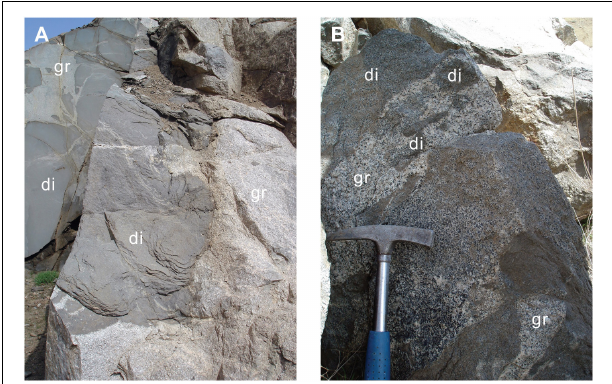
FIGURE 2 | Contact relations between dioritic (di) and granitic (gr) rocks of the Takht batholith. (A) Dioritic rock in sharp contact with and apparently cut by granitic rock; note the network of dikelets connecting to the main mass of granitic rock. (B) Centimeter-sized enclaves of diorite occur in granitic rock.